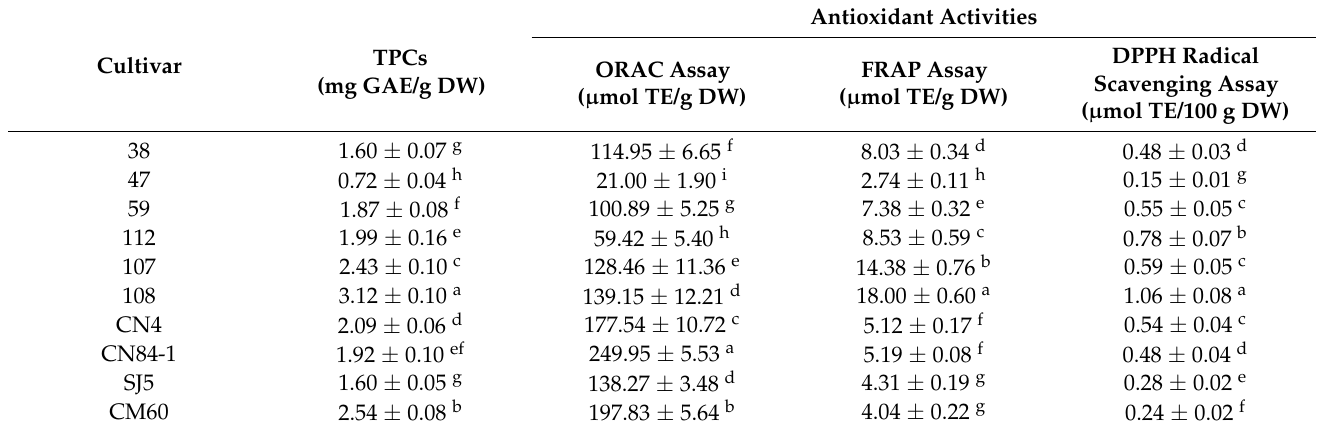
Table 5. Total phenolic contents (TPCs) and antioxidant activities of ten bean